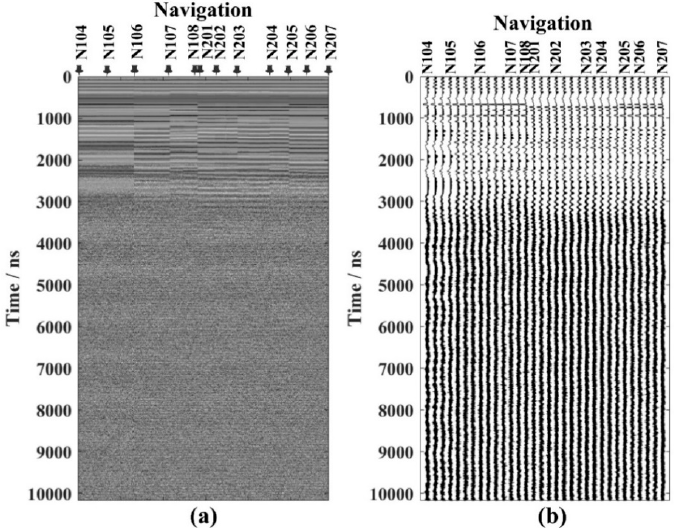
Figure 6. ( a ) LPR CH-1 overall data and ( b ) stagnation points’ traces after gain.